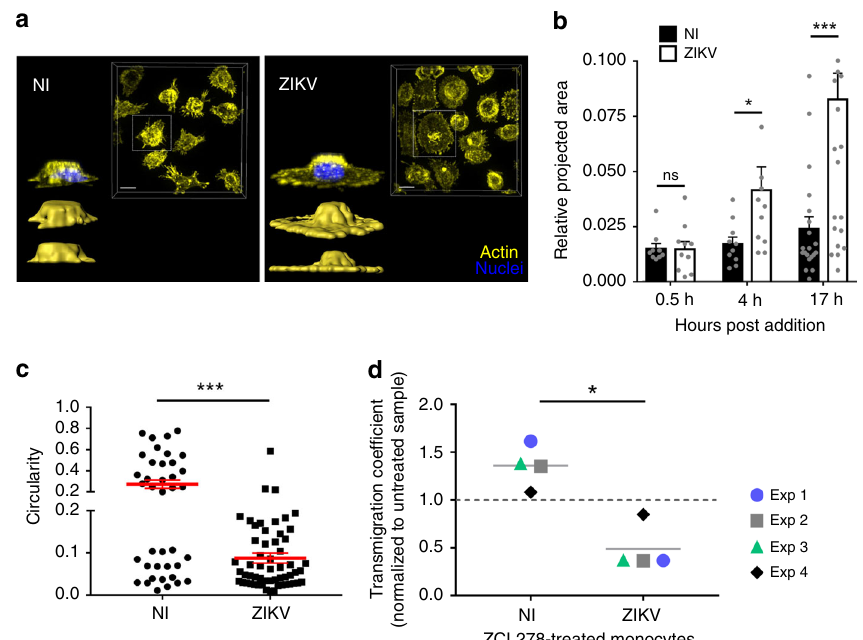
Fig. 6 ZIKV induces a spread-out morphology of monocytes. a Noninfected (NI) or ZIKV-infected monocytes were plated in wells coated with fi bronectin. Upon fi xation, cells were permeabilized and stained with Phalloidin A568 (yellow) and Dapi (blue). Images were acquired with a spinning-disk confocal microscope. For each condition, the images show a top view of the unprocessed fl uorescence signal of a fi eld of view (upper right) and isosurface- processed 3D reconstructions in the side view (down left). Scale bar: 10 µ m. b ZIKV-infected or noninfected (NI) monocytes from two healthy donors were added to hCMEC/D3 and processed as mentioned in Fig. 5g. The relative projected area (area covered by the surface of individual monocytes) was measured at the indicated times post monocyte addition to the endothelial layer. Each bar graph corresponds to an experiment performed on monocytes from two donors showing the mean + / − SEM from two individual experiments. c Circularity of individual monocytes was measured 17 h after monocyte – hCMEC/D3 coculture by using ImageJ. Each dot corresponds to a single monocyte and the red bars correspond to the mean ± SEM from two individual experiments from two donors. A circularity value of 1 indicates a perfect circle and as the value approaches 0, it indicates an increasingly elongated polygon. d A transmigration assay in a transwell was performed with noninfected (NI) or 48 h ZIKV-infected (ZIKV) monocytes in the presence or absence of 50 µ M ZCL278. The ratio of transmigrating cells between ZCL278-treated and untreated samples is shown. Each dot corresponds to an individual donor. Two-tailed p value was nonsigni fi cant (ns), <0.05 (*) or <0.0005 (***). Statistical signi fi cance was determined by using a t test. Source data in b – d are provided as a Source Data fi